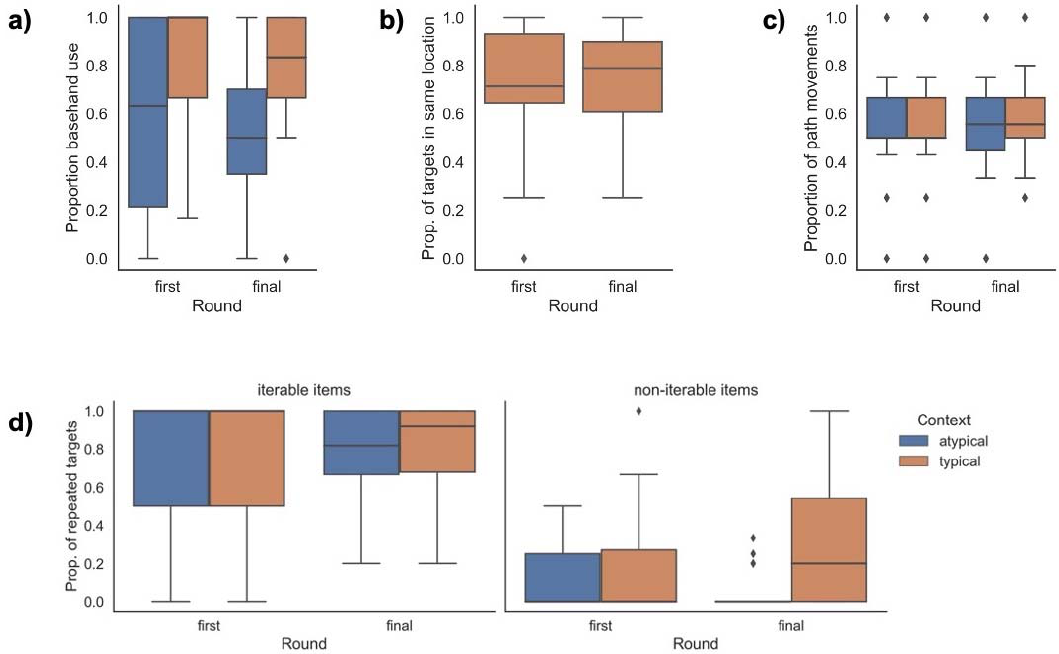
Figure 6. Gesture form analyses for experiment 1, showing base hand use ( a ), proportion of target action gestures produced in the same location for typical and atypical contexts ( b ), gesture size ( c ) and repetitions shown for iterable and non ‐ iterable target actions ( d ).